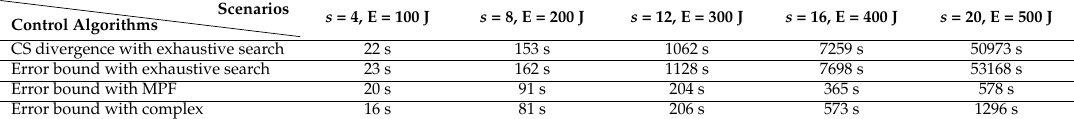
Table 5. 200 MC run averages of computer processing unit (CPU) processing time (Unit: s). Control